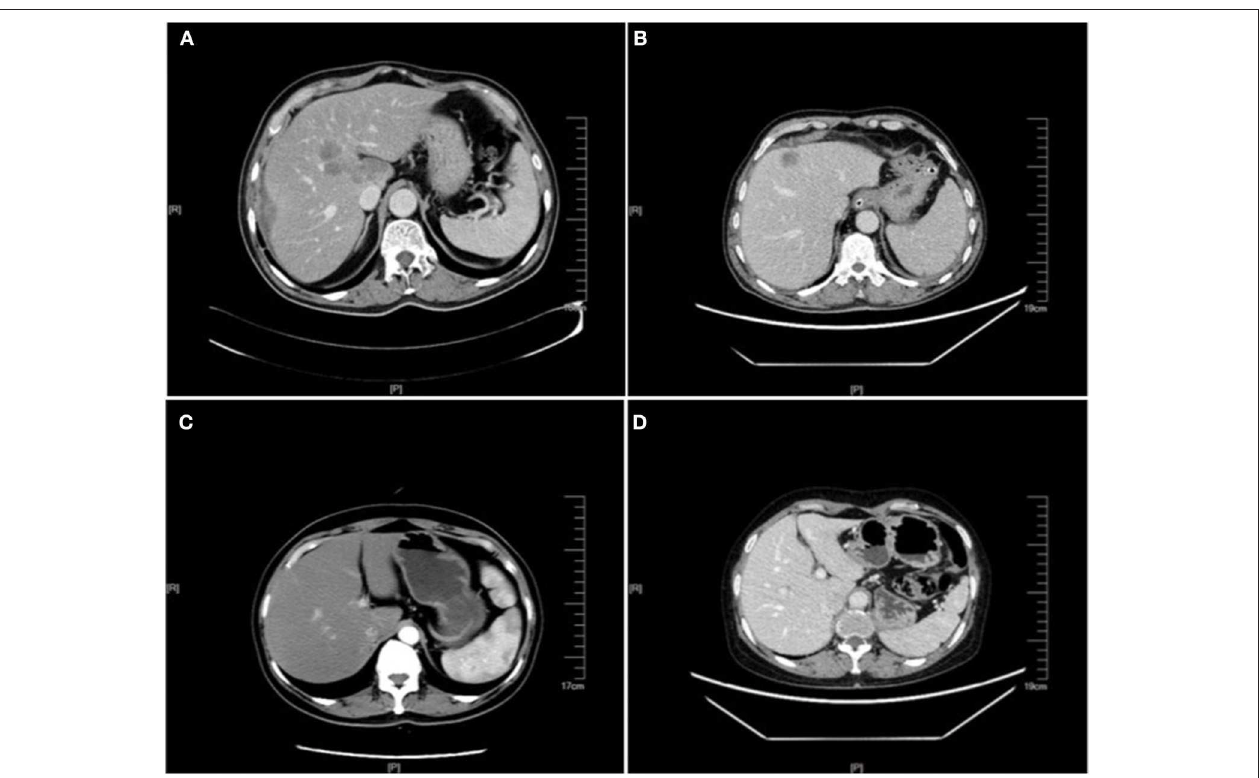
FIGURE 1 | Enhanced CT images of liver metastasis, NAFLD and normal liver in the CRC patients. (A) NAFLD group, synCRLM + : The shape of the liver was regular, and the proportion of each lobe was within the normal range. The density of the liver parenchyma was lower than that of the spleen in each stage of enhancement, and multiple round-like enhancement shadows could be seen in the liver parenchyma with unclear boundary. (B) Control group (without NAFLD), synCRLM + : A patchy abnormal enhancement foci with unclear boundary was seen in the left inner lobe of the liver, showing slight enhancement, while no abnormal density or enhancement was observed in the remaining liver parenchyma. (C) NAFLD group, synCRLM − : The density of liver parenchyma decreased, which was lower than that of the spleen in the same layer. (D) Control group (without NAFLD), synCRLM − : No abnormal density and enhancement foci were found in the liver